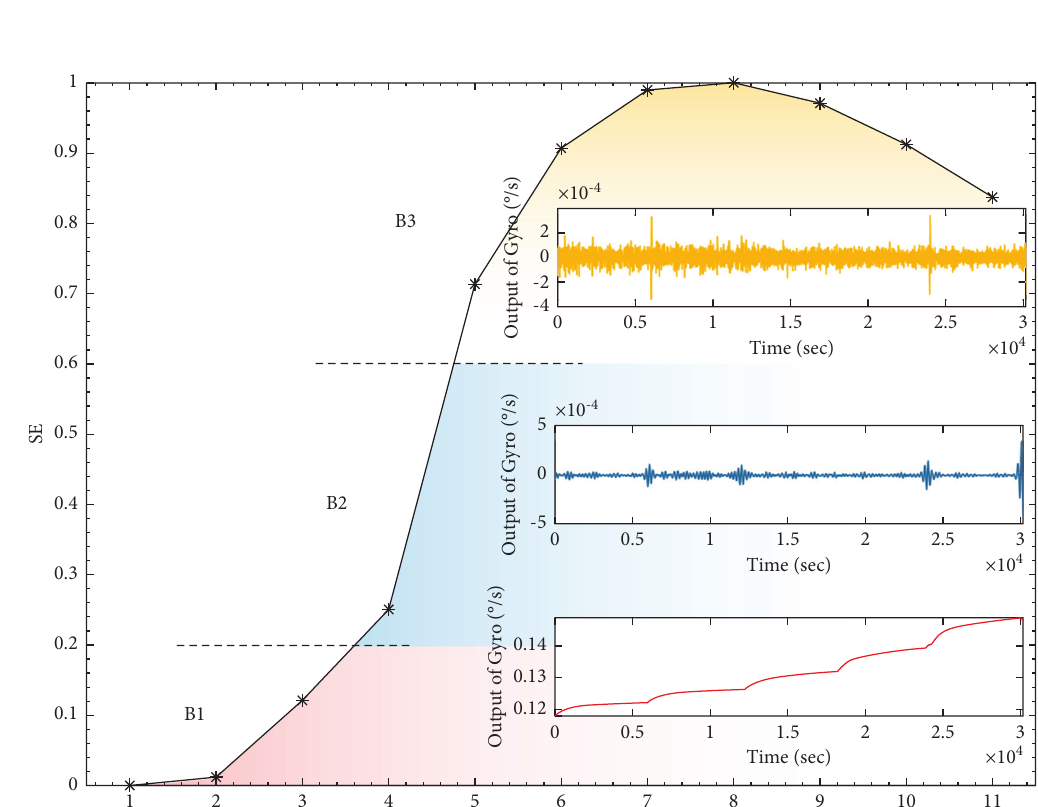
Figure 12: The result of sample entropy